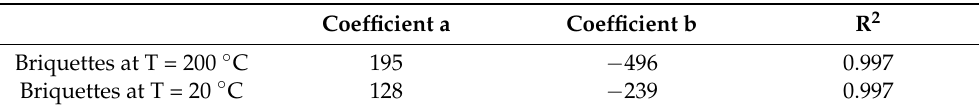
Figure 9. Density of compacted biomass versus pressure and temperature of compaction ( a ) in log scale; ( b ) in linear scale. Table 1. Coefficients of Equation (13) and the regression coefficient R 2